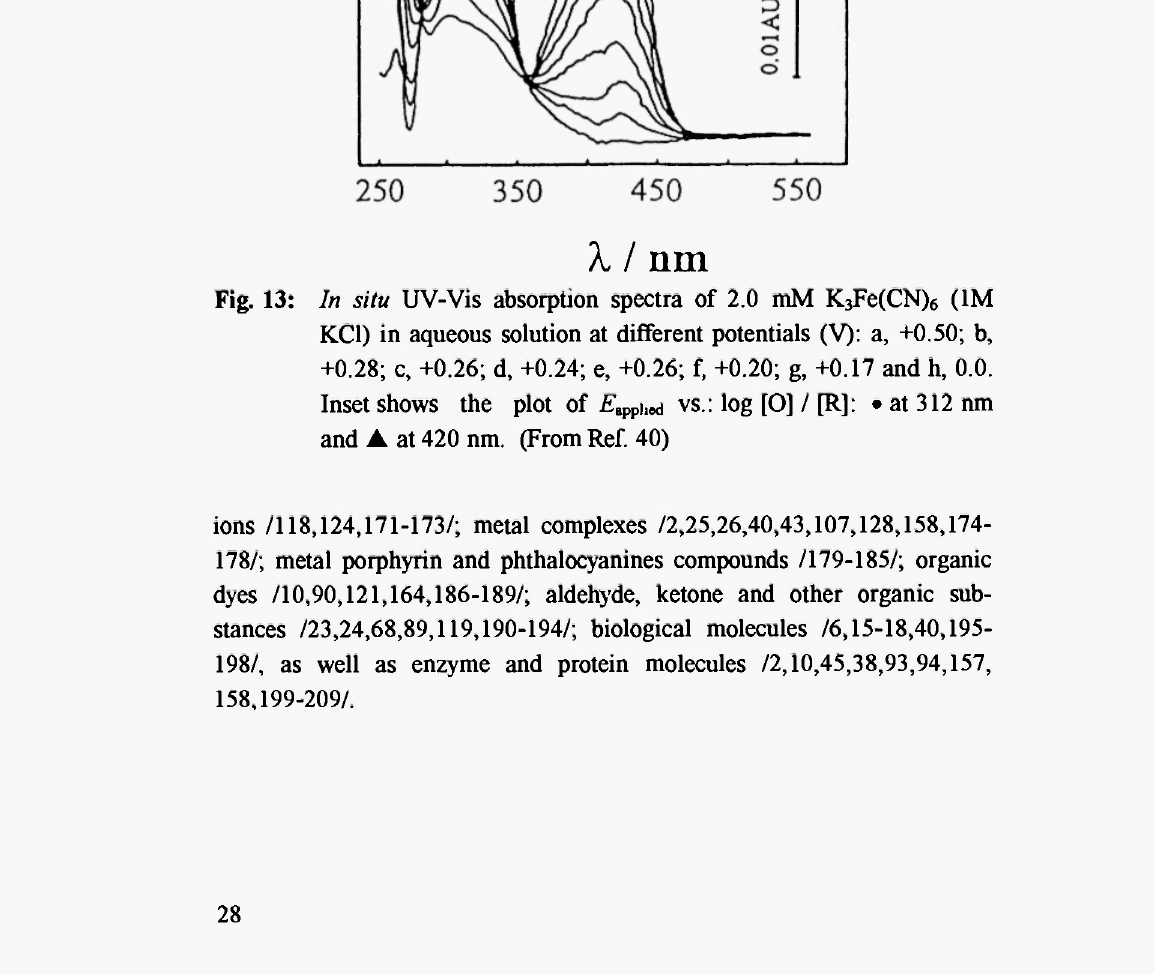
Fig. 13: In situ UV-Vis absorption spectra of 2.0 mM K 3 Fe(CN) 6 (1M KCl) in aqueous solution at different potentials (V): a, +0.50; b, +0.28; c, +0.26; d, +0.24; e, +0.26; f, +0.20; g, +0.17 and h, 0.0. Inset shows the plot of £ 8ρρ)ι «ι vs.: log [O] / [R]: · at 312 nm and • at 420 nm. (From Ref. 40)